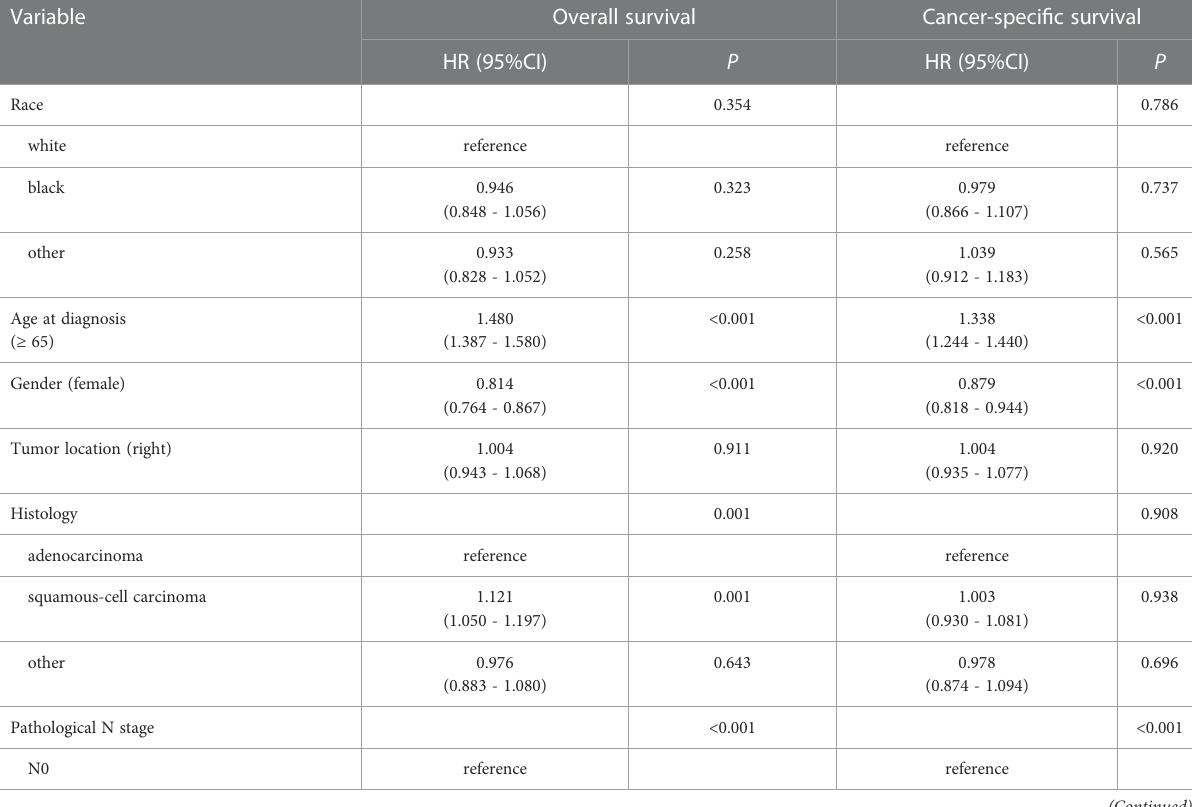
TABLE 2 Univariable analysis for overall survival (OS) and cancer-speci fi c survival (CSS) of all patients (n=6479).